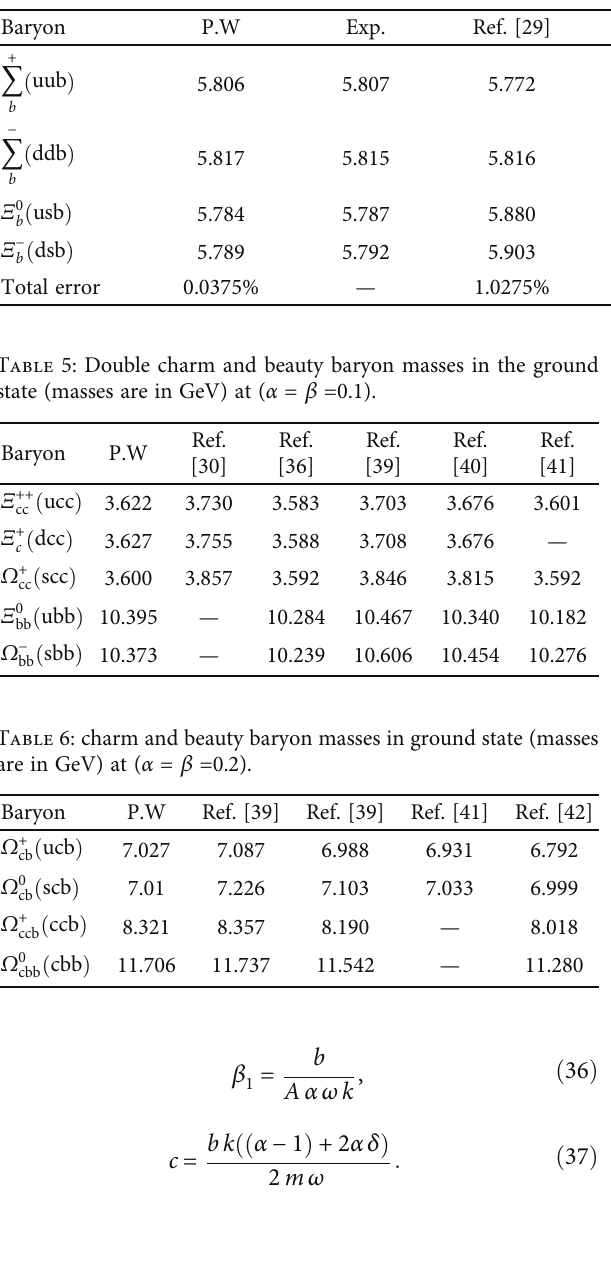
Table 4: Single beauty baryon masses in ground state (masses are in GeV) at ( α = β =0.56). The last column shows the relative error in comparison to experimental data.